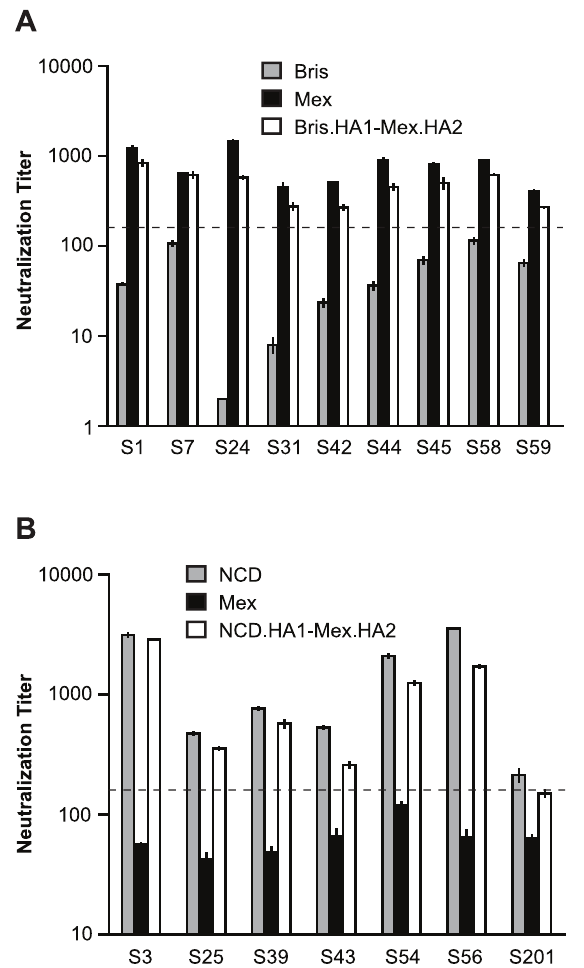
Figure 5. HA2 influences cross-neutralization between Mex/ 4108/09 and recent seasonal H1N1 influenza A strains. (A) Bris.HA1-Mex.HA2 pseudotypes were used to map the target of cross- neutralizing antibodies in the samples with cross-neutralization titers to Mex/4108/09, but not to Bris/59/07, in sera from the contemporary cohort of subjects who received seasonal influenza vaccines. (B) Neutralization to NCD/20/99, but not to Mex/4108/09, was mapped to NCD/20/99 HA1 using NCD.HA1-Mex.HA2 pseudotypes and sera from the contemporary cohort of subjects who received seasonal influenza vaccines. The dotted lines in both panels A and B represent the neutralization titer of 160, which has been proposed as a correlate of seroprotection in microneutralization assays involving replicating influenza virus [4]. Protective titers for neutralization of HA-pseudotypes have not been determined. Data are shown as means + / 2 SD and reflect two or more independent experiments with each sample run in duplicate. Bris: Bris/59/07; Mex: Mex/4108/09; NCD: